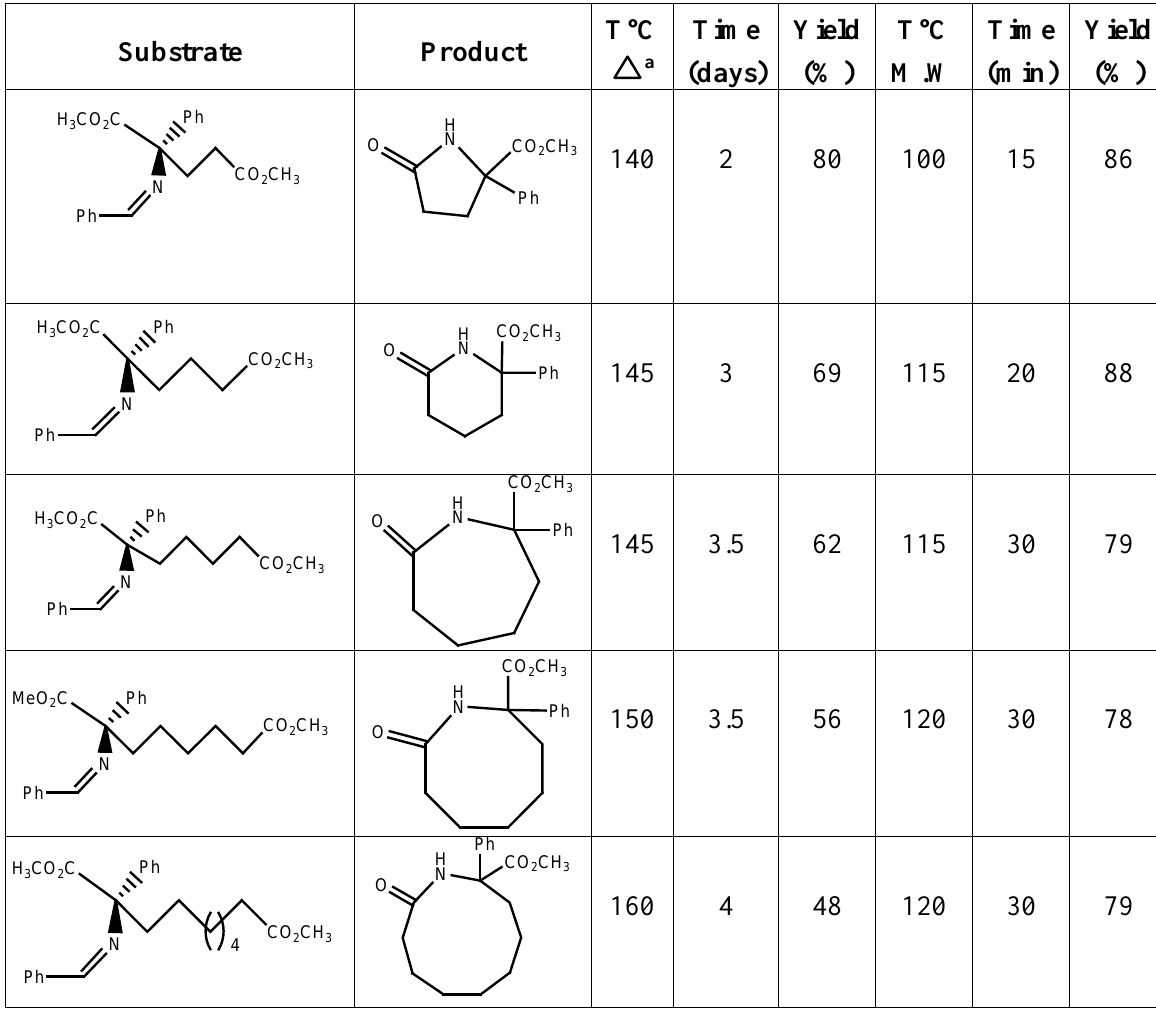
Table 4: Intramolecular cyclization of imines 1 with R = Ph